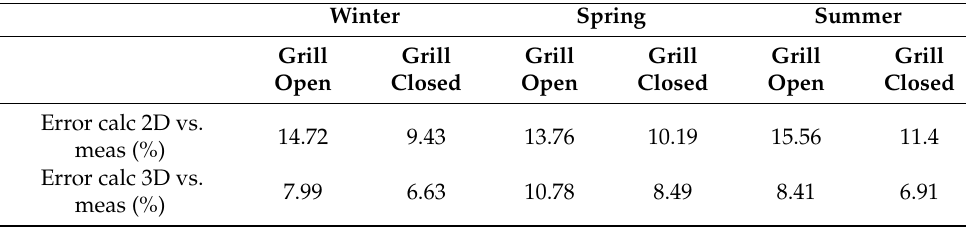
Table 12. Error for daily heat flux through the OVFs for 2D and 3D computations. Winter Spring Summer Open Closed Closed Error calc 2D